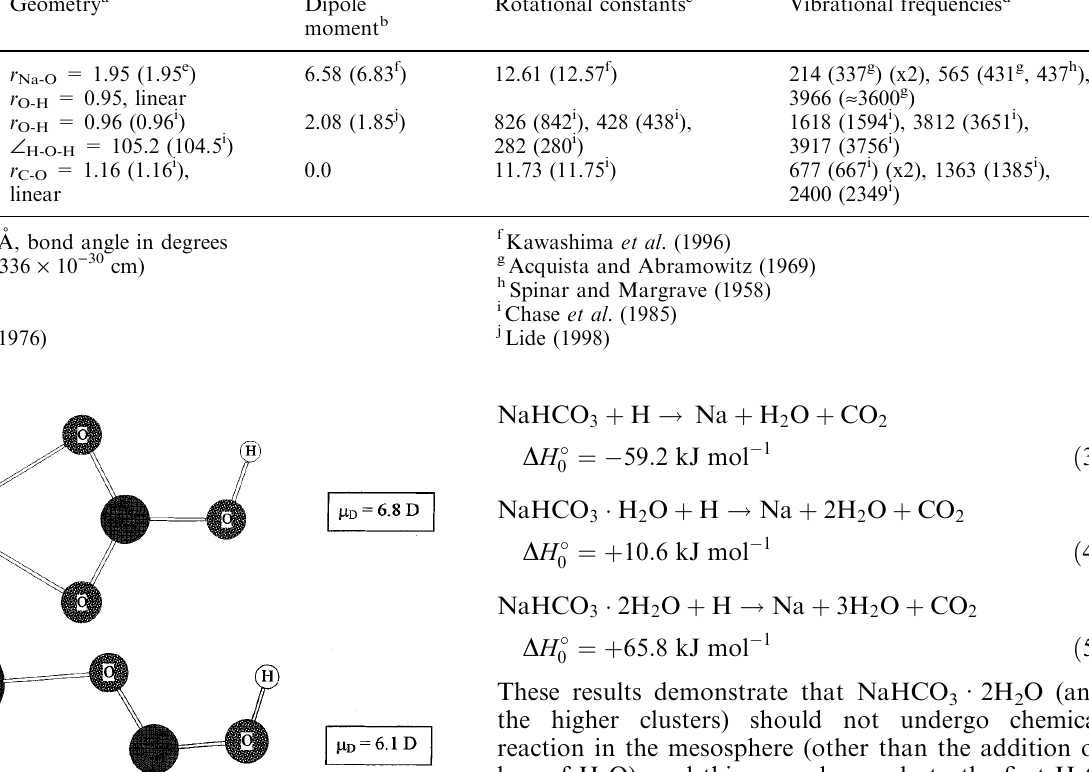
Table 1. Calculated molecular parameters at the B3LYP/6-311+G(2d,p) level of theory for NaOH, H experimental values are shown in parenthesis Species